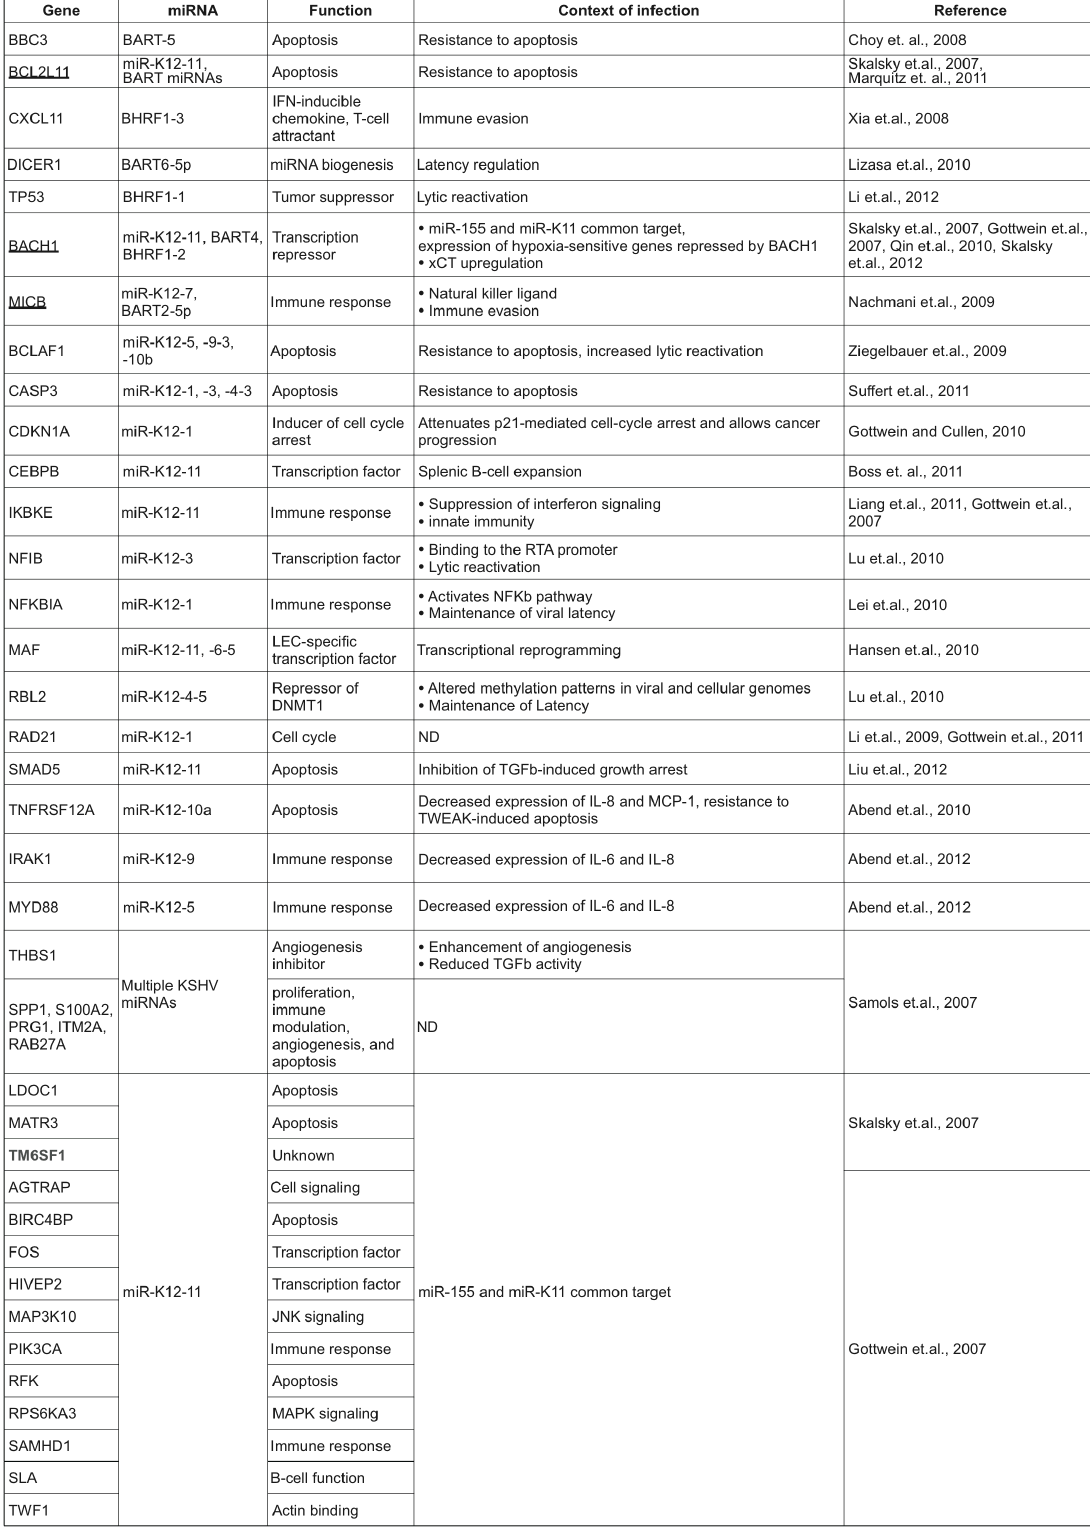
Table 1. List of experimentally validated cellular targets of KSHV- and EBV- encoded miRNAs. The normal cellular functions of these proteins and the effect of their knockdown during viral infection are also listed. The targets that are underlined are repressed by both KSHV- and EBV-encoded miRNAs. ND- No